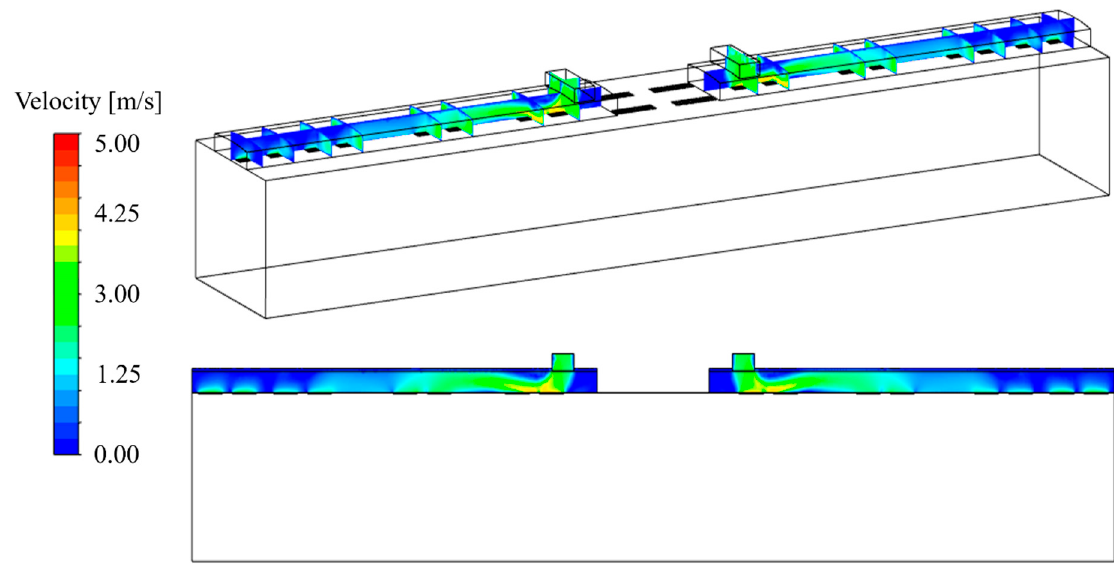
Figure 3. Air velocity distribution in the HVAC air supply